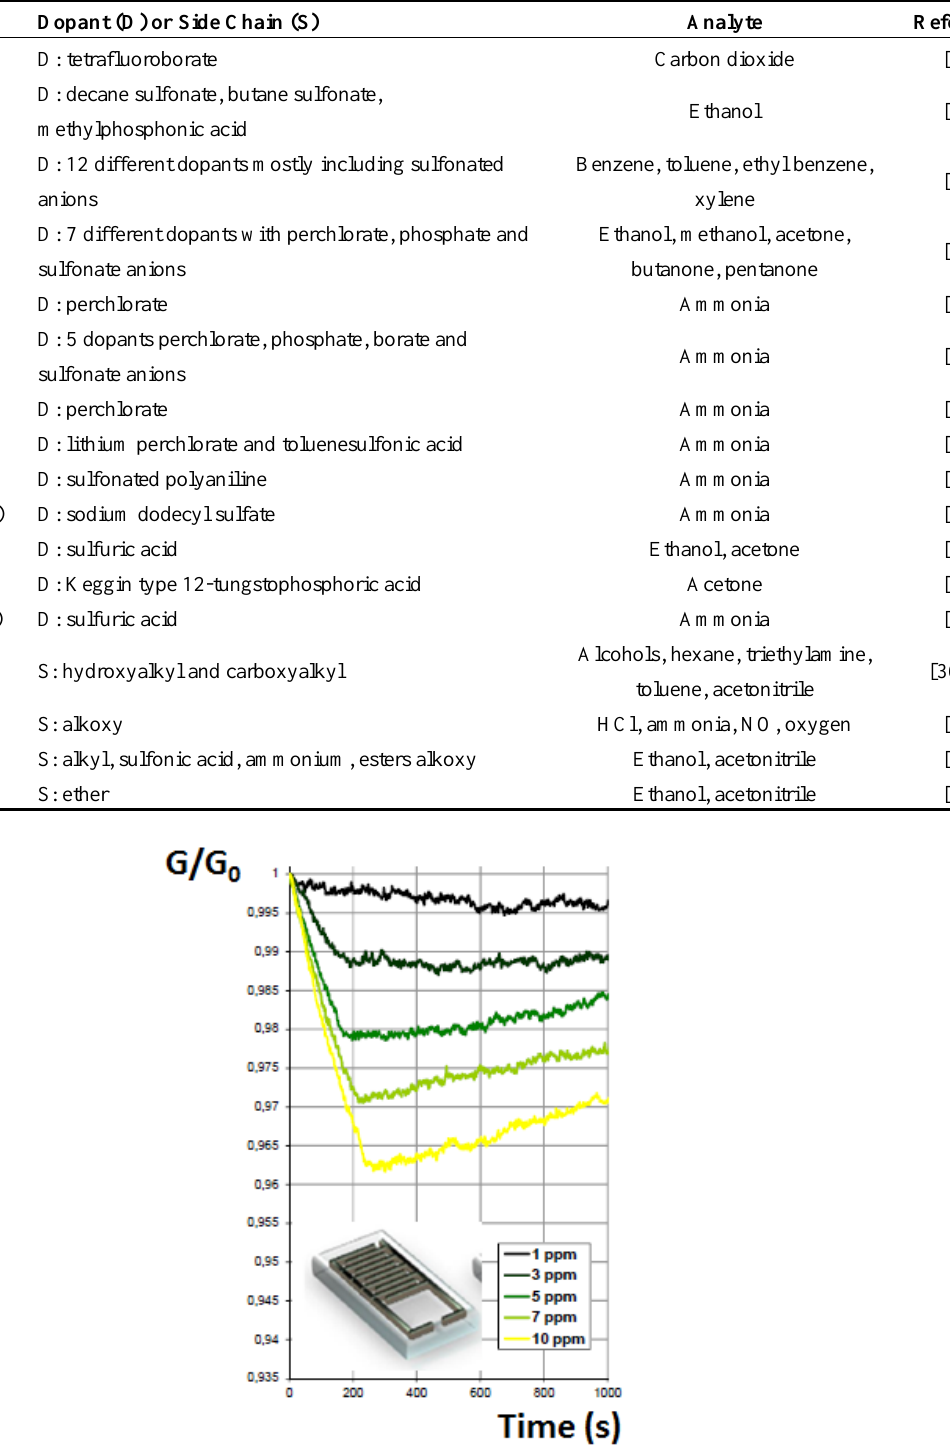
Table 1. Electrodeposited polymers and polymer derivatives used for gas sensing.